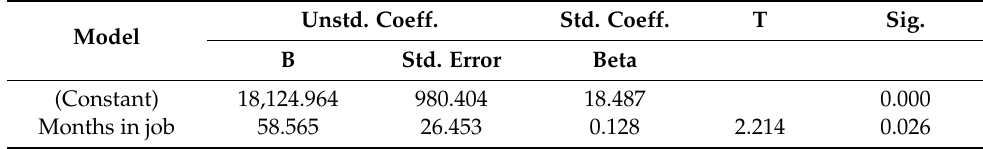
Table 1. Regression of time in job and average income of migrants in Costa Rica. Unstd. Coeff. Std. Coeff. T Sig. Model B Std. Error Months in